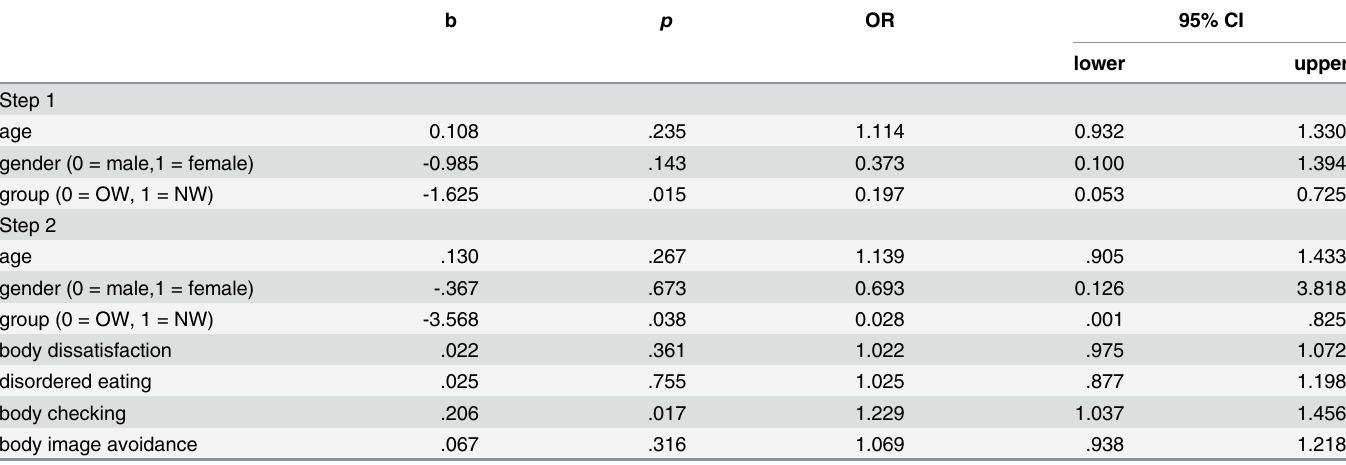
Table 3. Logistic regression for the prediction of a positive attentional